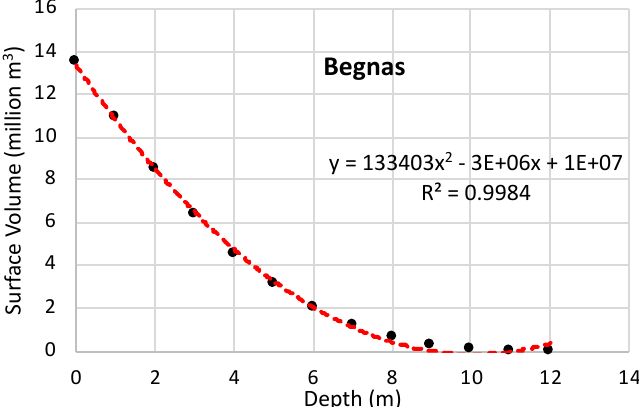
Figure 5. Relationship between water volume and depth of Begnas Lake.